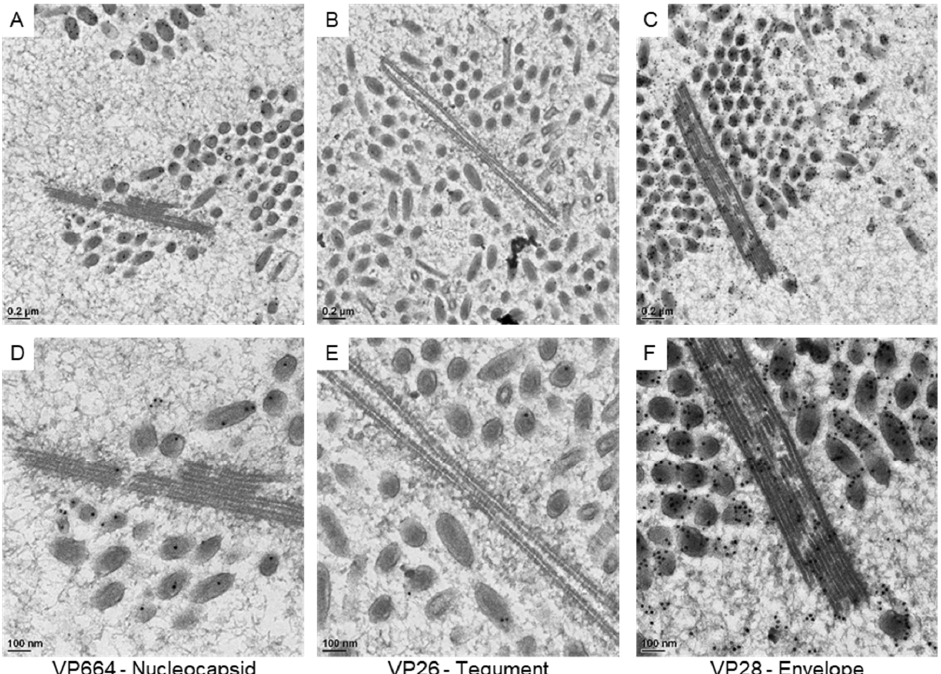
Figure 5. The expressions of viral proteins on the sheet-like structures in the WSSV-positive nucleus. The represented images show the immuno-gold labeling of the nucleocapsid protein VP664 ( A ), the envelope protein VP28 ( B ), and the tegument protein VP26 ( C ) in the nucleus. ( D – F ): The high magnification view of the sheet-like structure is shown in ( A – C ), respectively.